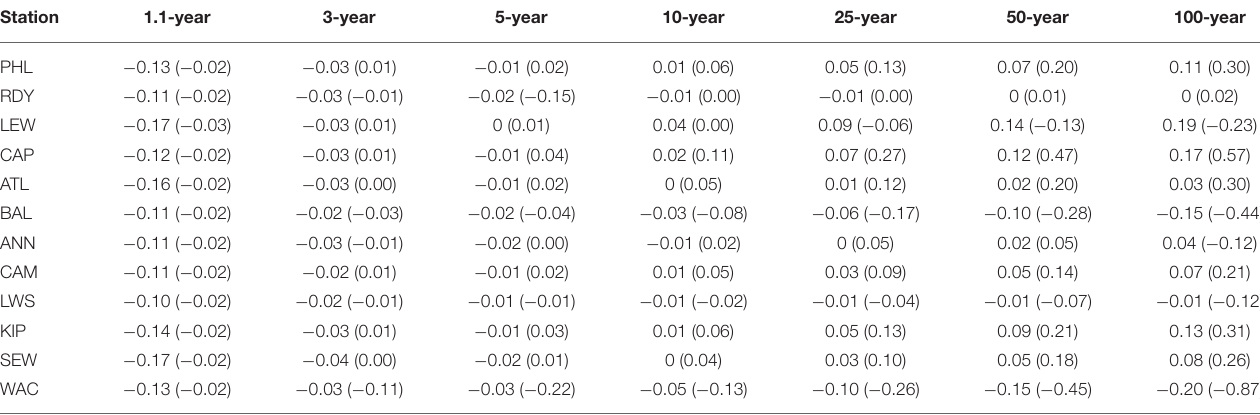
TABLE 7 | Difference in estimated skew surges and 90% confidence intervals (in parentheses) for 1.1, 3, 5, 10, 25, 50, and 100-year return periods modeled from GEVr and GP distribution for tide gauges in the Mid-Atlantic region.